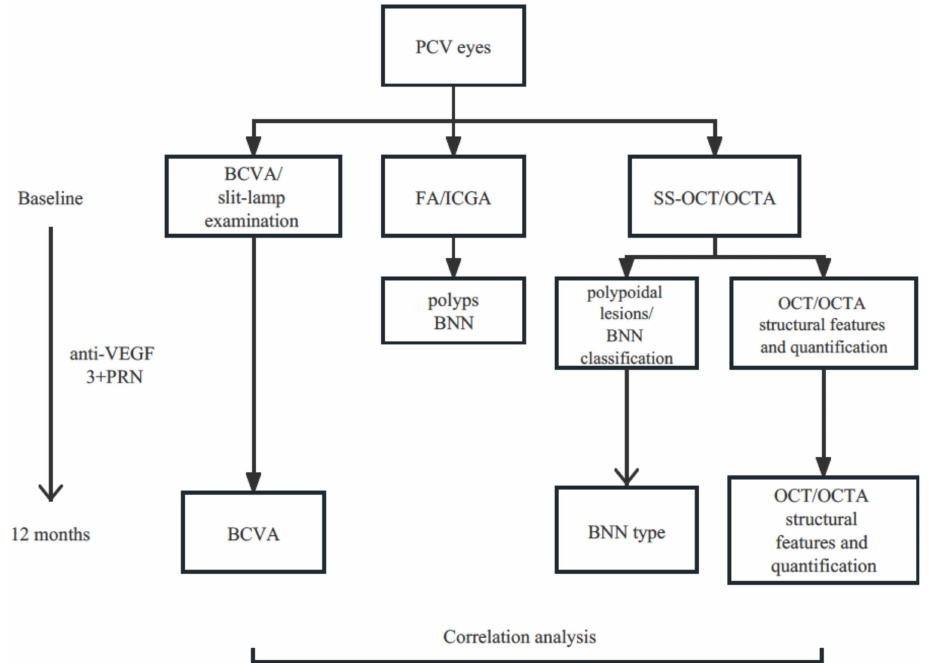
Figure 2. Flow chart demonstrating a simplified study protocol. PCV, polypoidal choroidal vascu‑ lopathy; BCVA, best corrected visual acuity; FA, fluorescein angiography; ICGA, indocyanine green angiography; SS‑OCT, swept source optical coherence tomography; OCTA, optical coherence tomog‑ raphy angiography; BNN, branching neovascular network; VEGF, vascular endothelial growth fac‑ tor; PRN, pro re